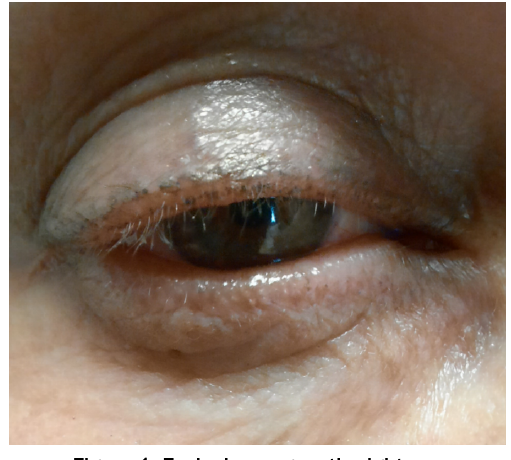
Figure 1: Eyelashes regrowth, right